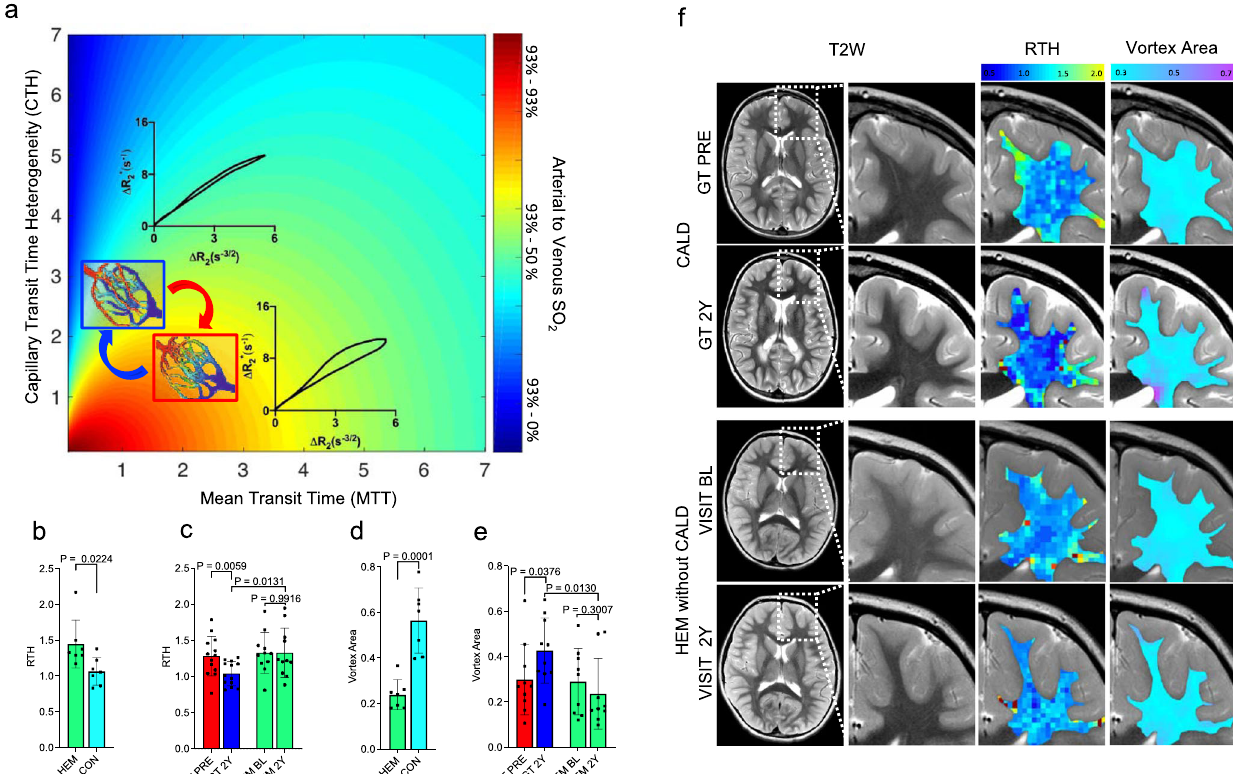
Fig. 3 | Effects of gene therapy on non-lesional white matter microvascular function. a Theoretical relationship between the imaging parameters capillary transit time heterogeneity (CTH) and mean transit time (MTT, an overall tissue perfusion marker) regarding the oxygen saturation of the perfused tissue. Flow disturbances in the capillary system lead to a mismatch between MTT and CTH (quanti fi able as increased relative transit time heterogeneity=RTH). The micro- vascular fl ow delay results in increased oxygen extraction in the capillary bed ( Δ SO 2 )indicatingareductioninvascularef fi cacy.Thisaffectstherelaxationcurves from MRI gradient- and spin-echo signalsand forms a reduced relative vortex area (VA). b Mean RTH in corresponding NAWM of HEM and controls without ALD (CON, n =7). Data are expressed as mean±SD; the P values were determined by two-tailedunpairedstudents ’ t tests. c MeanRTHindistantnormal-appearingwhite